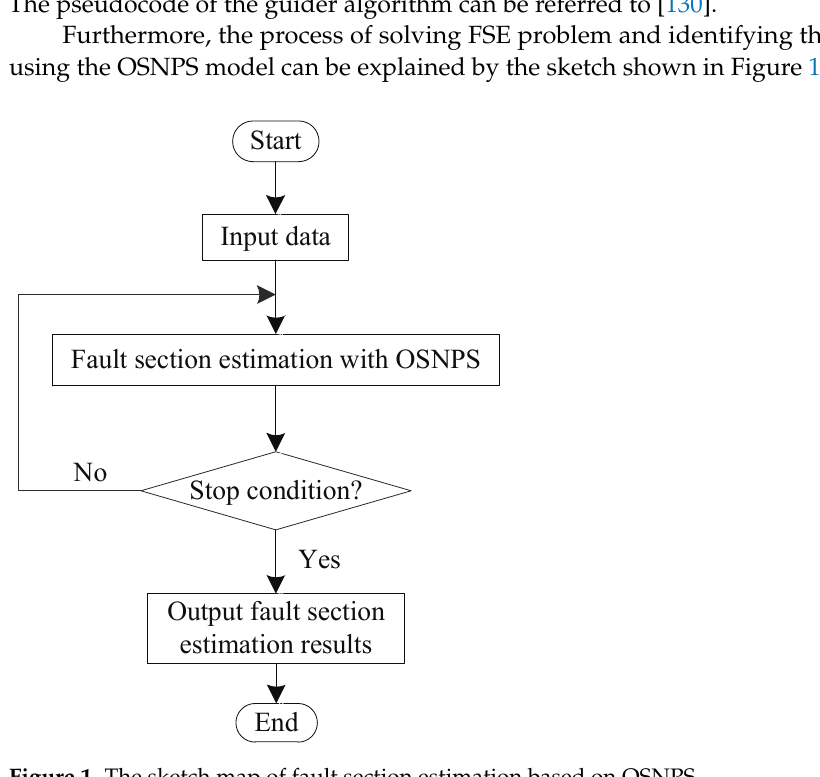
Figure 1. The sketch map of fault section estimation based on Fig. 5. The sketch map of fault section estimation based on OSNPS.